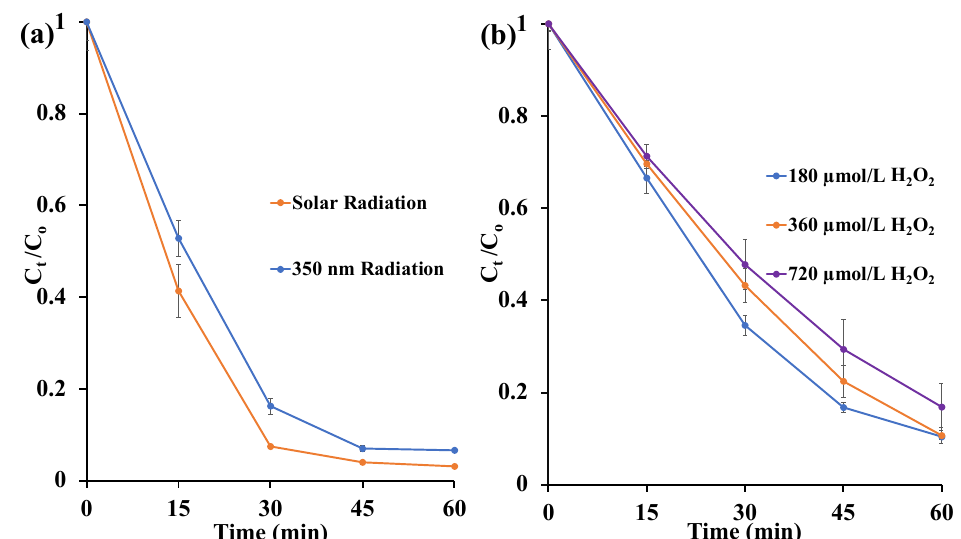
Figure 4. ( a ) Influence of sunlight on the degradation of 4 mg/L MB at 290 µ mol Fe/L (1000 mg St–Fe), 360 μ mol/L H 2 O 2 , and pH 4; ( b ) influence of H 2 O 2 concentration on the degradation of 4 mg/L MB at 290 μ mol Fe/L (1000 mg St–Fe) and pH 4.